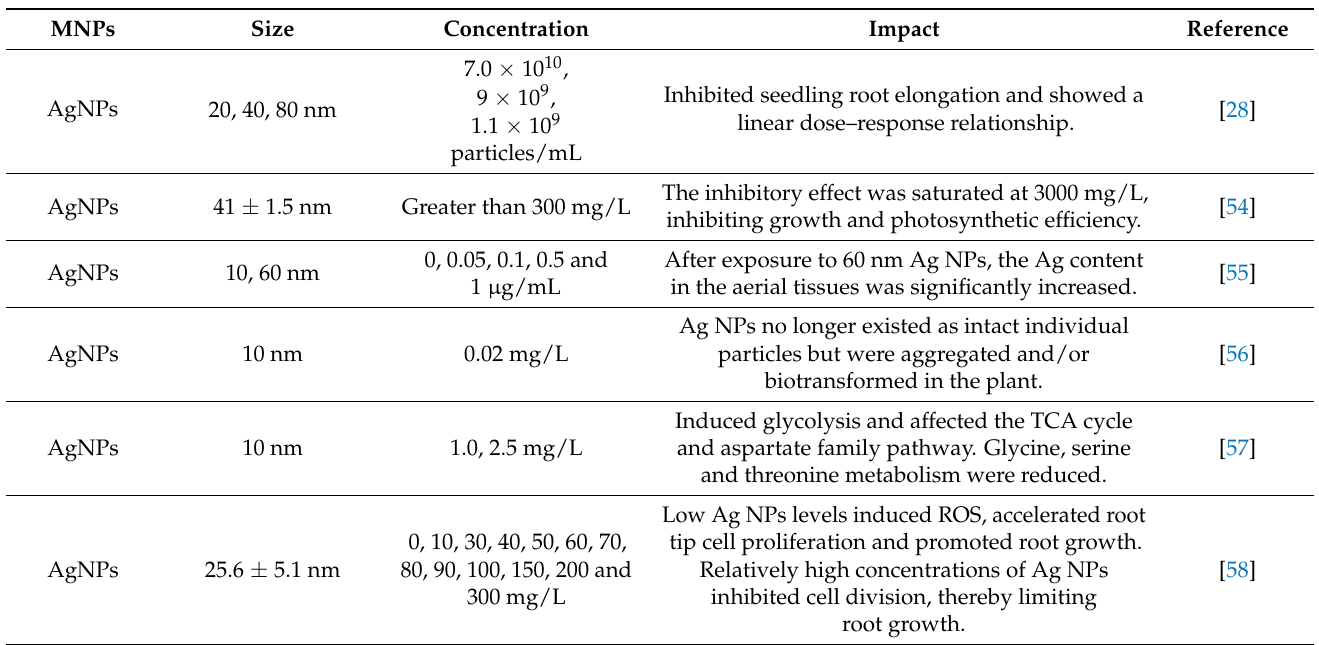
Table 1. Toxic effects of various MNPs in Arabidopsis